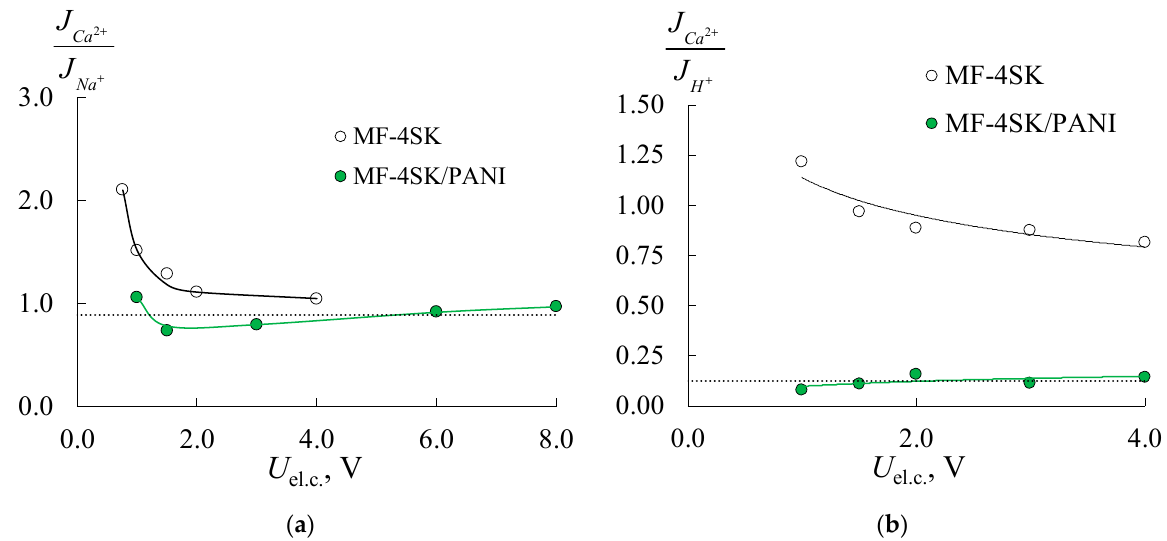
Figure 13. Theoretical (dashed line) and experimental (points and solid lines) dependencies of Ca 2+ /Na + ( a ) and Ca 2+ /H + ( b ) flux ratios for the initial MF-4SK and composite MF-4SK/PANI membranes.